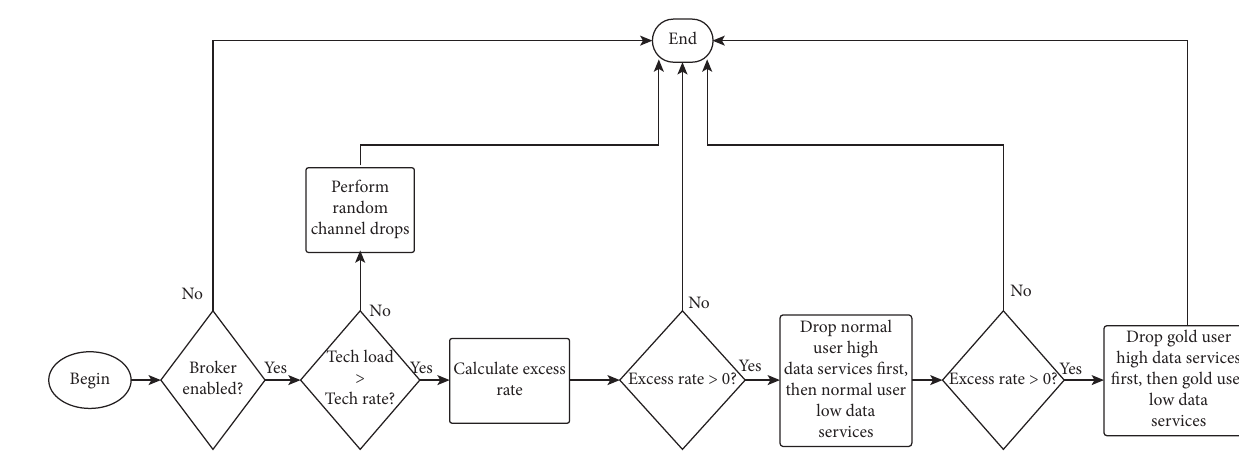
Figure 4: Flow drop flowchart.